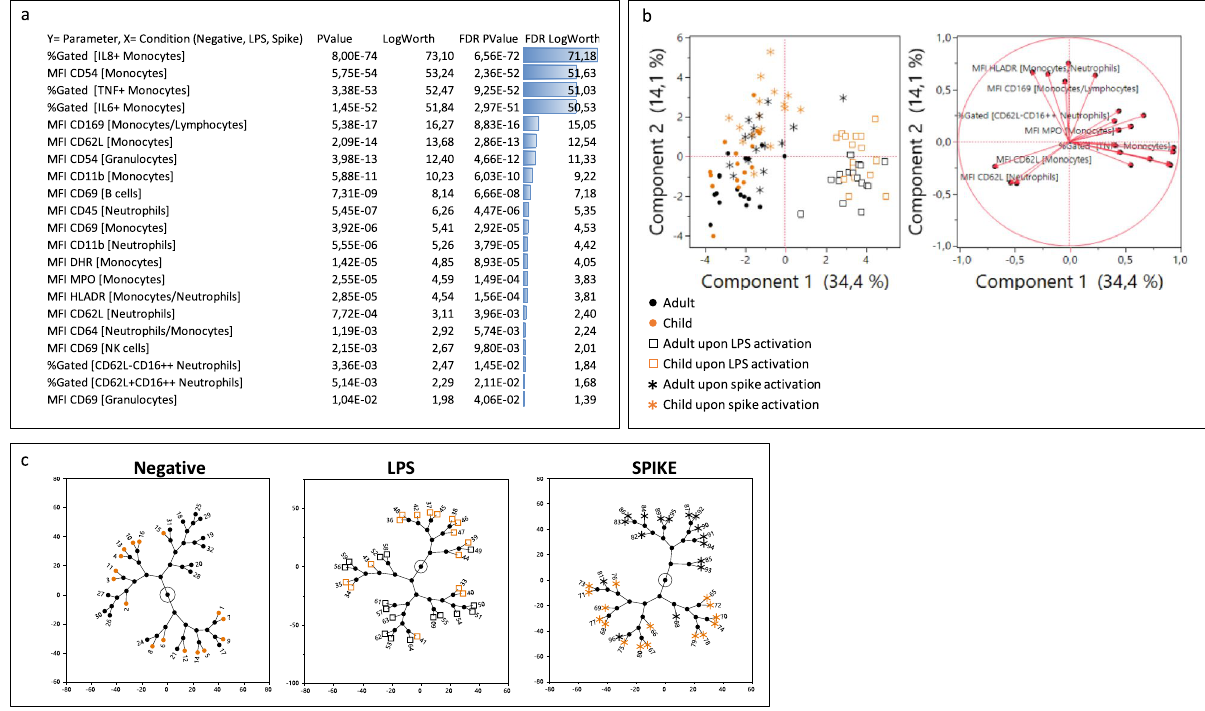
Figure 2. Unsupervised analysis of the biological parameters considered: ( a ) response screen comparing non-stimulated, LPS and spike conditions showing the most discriminant features. ( b ) PCA analysis of the best discriminators. ( c ) Constellation clustering analysis of the best factors. Orange color represents children and black adults. Squares illustrate LPS condition and asterisks spike